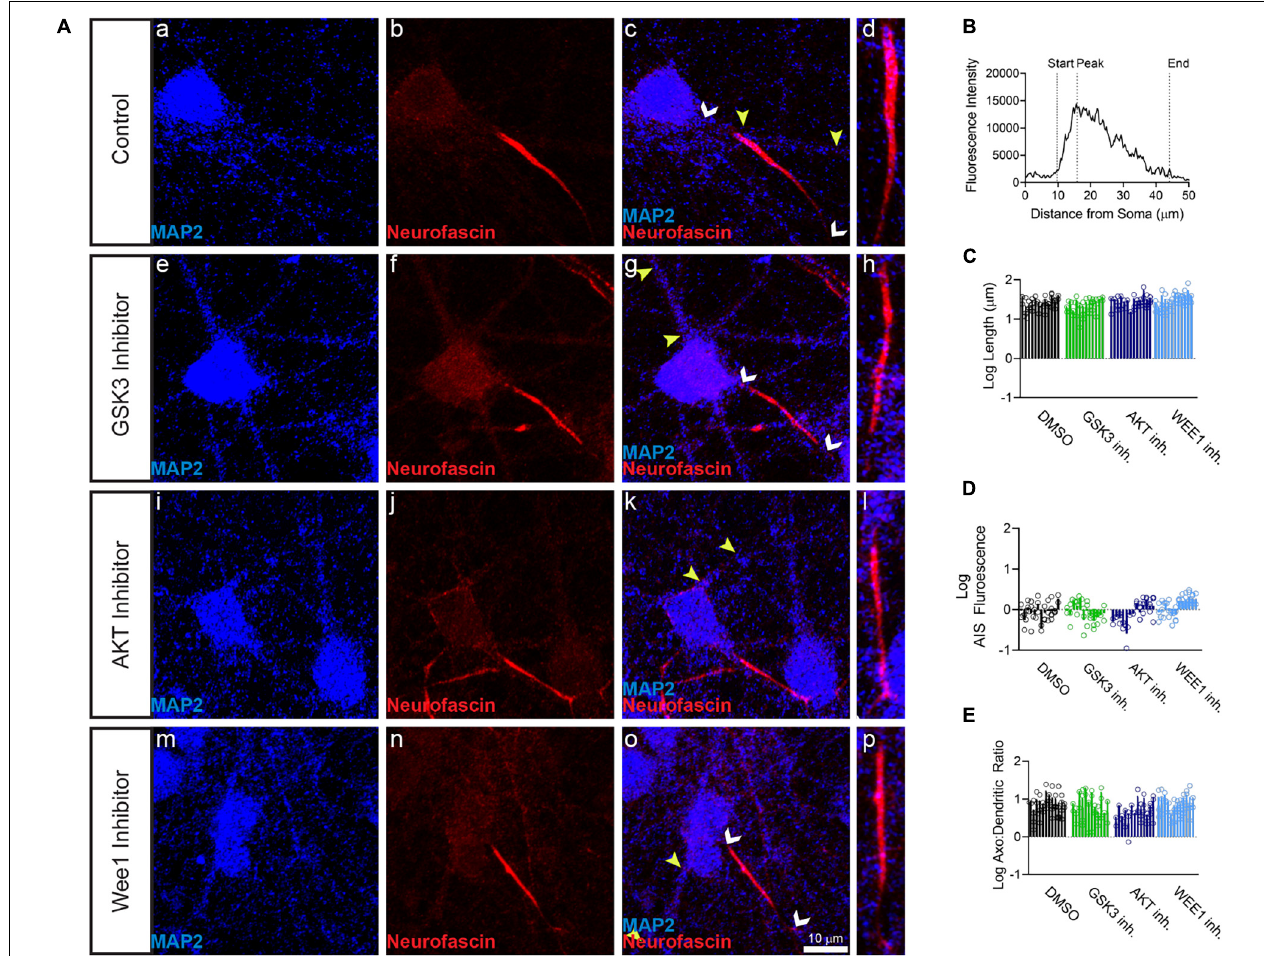
FIGURE 2 | Neurofascin fluorescent intensity is unaffected by kinase inhibitor treatment. (A) Representative images of expression of (a,e,i,m) MAP2 (blue), (b,f,j,n) neurofascin (red), (c,g,k,o) merge of all channels with white arrows indicating the AIS and yellow arrows indicating a dendrite, (d,h,i,p) zoom to AIS. (a–d) Neurons treated with 0.5% DMSO (control). (e–h) Neurons treated with 5 µ M GSK3 inhibitor CHIR99021. (i–l) Neurons treated with 25–30 µ M AKT inhibitor triciribine. (m–p) Neurons treated with 5–10 µ M Wee1 kinase inhibitor II. (B) Profile of neurofascin fluorescent intensity from the AIS highlighted in panel (d) with the peak of fluorescent intensity, AIS start and AIS end noted as described in the “Materials and Methods”. (C) None of the kinase inhibitors examined altered the length of the neurofascin + AIS (GSK3 inhibitor p = 0.2426; AKT inhibitor p = 0.8066; Wee1 kinase inhibitor II p = 0.4303), (D) the fluorescent intensity of neurofascin at the AIS (GSK3 inhibitor p > 0.9999; AKT inhibitor p = 0.9672; Wee1 kinase inhibitor II p = 0.1087), or (E) axo:dendritic ratio (GSK3 inhibitor p = 0.7654; AKT inhibitor p = 0.0505; Wee1 kinase inhibitor II p = 0.9944). All data are mean ± SEM using a separated scatter graph with